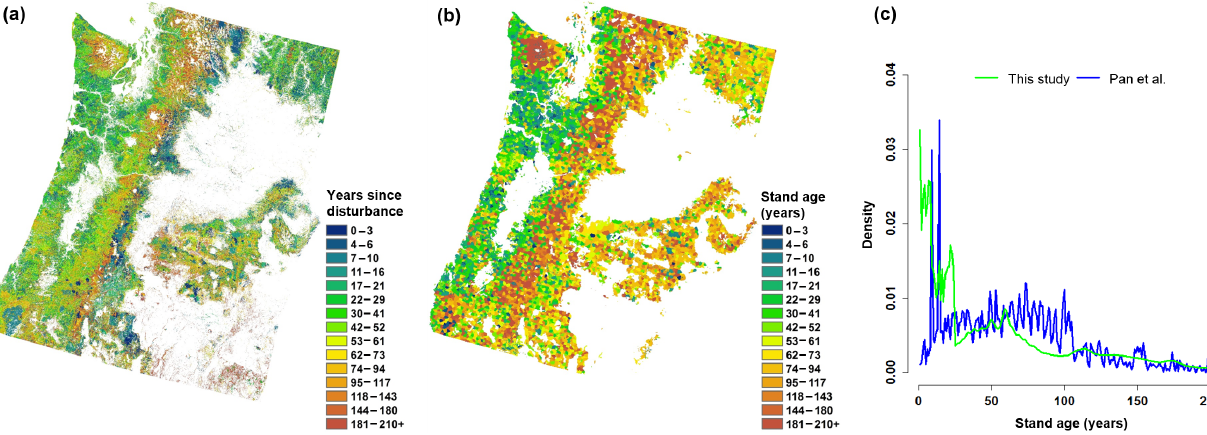
Figure 9. Maps of time since disturbance from (a) this study (same as Fig. 7a) and stand age from (b) Pan et al. (2011) in the PNW region. Associated density curves of stand age are plotted in (c)